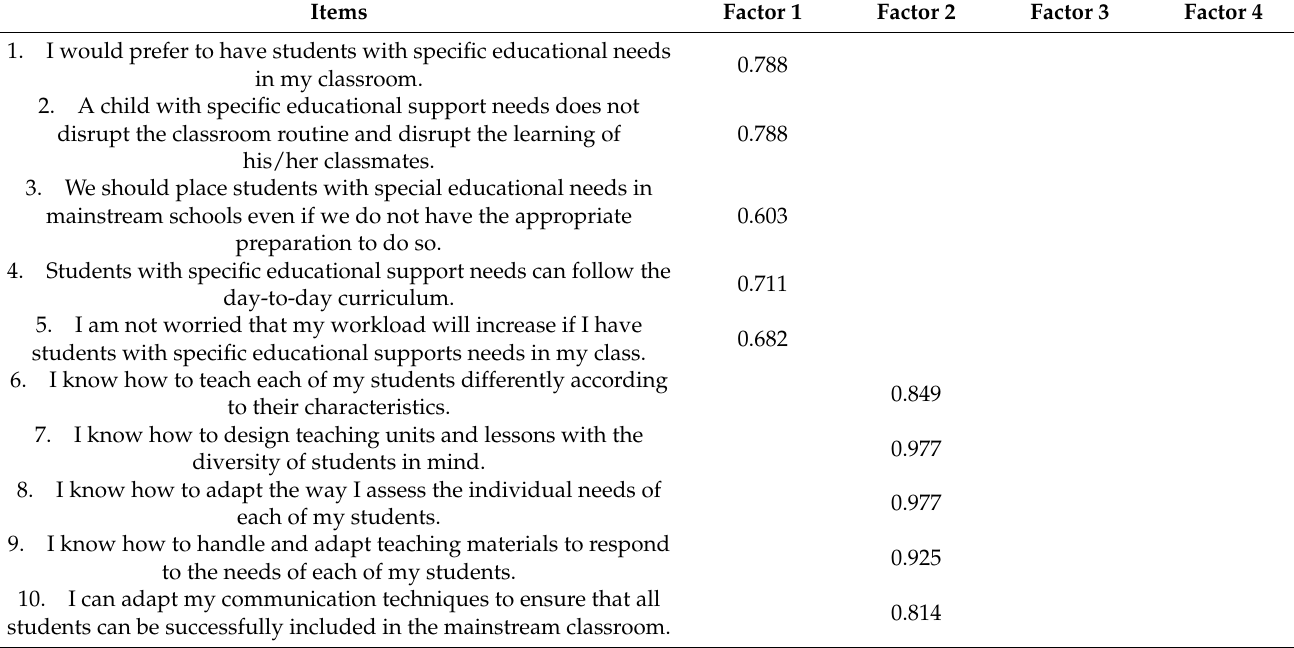
Table 4. CEFI-R questionnaire rotated factor solution and factor